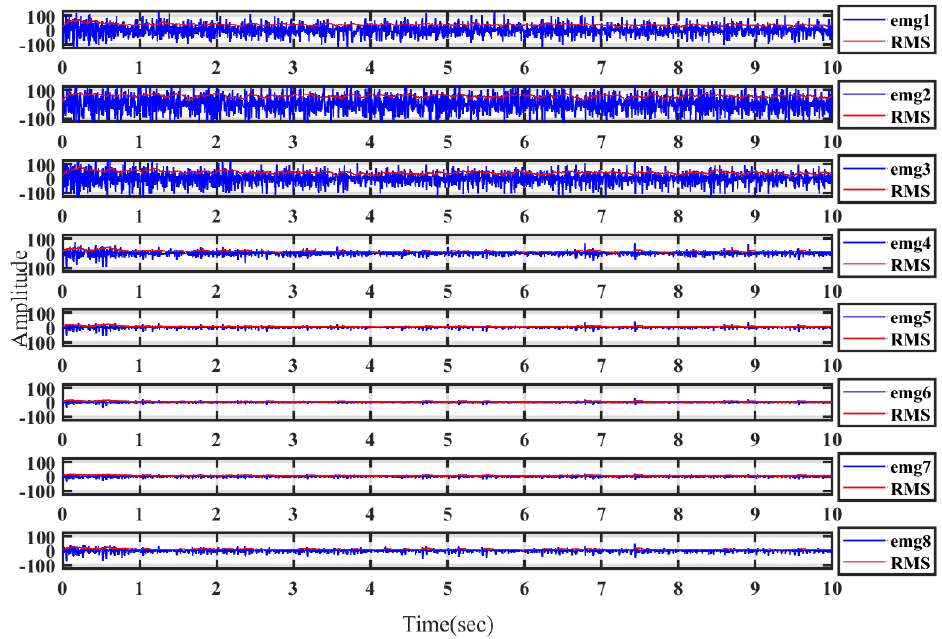
Figure 25. Gesture 4 (wave-out) maintained for 10 s. The EMG signal and RMS graph of the eight sensors in the sEMG bracelet.